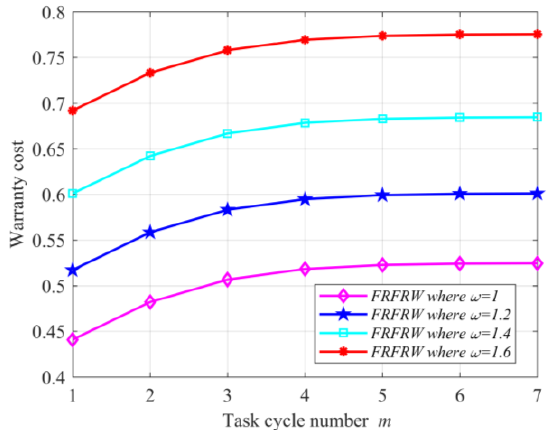
Figure 2. The impacts of m and on the warranty cost of the FRFRW.